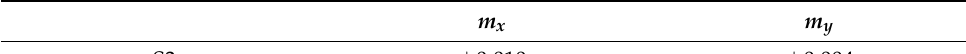
Table A5. Obtained coordinates errors.